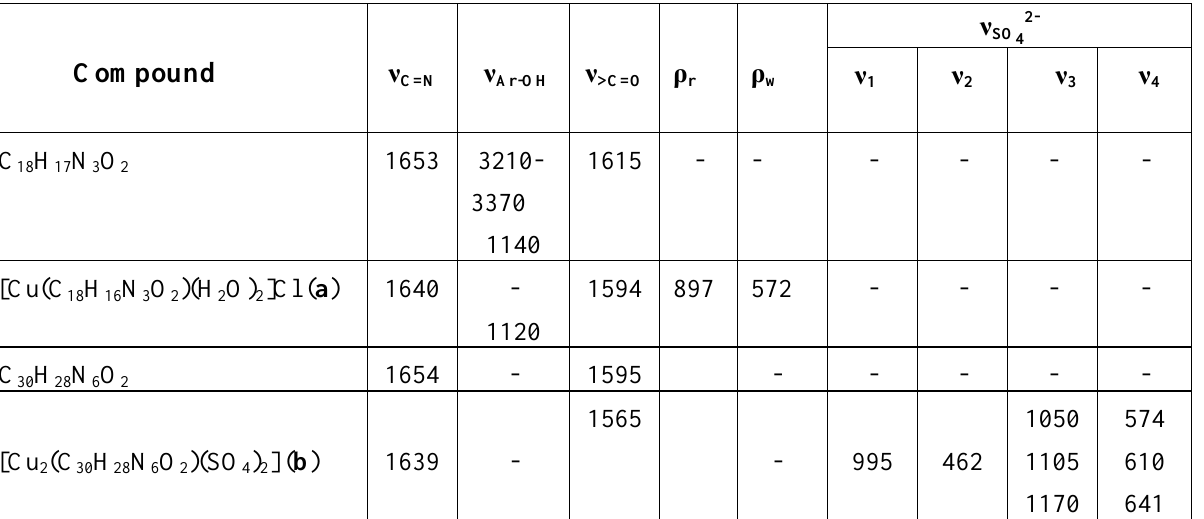
Table 1: IR spectral data for the prepared ligands and complexes.